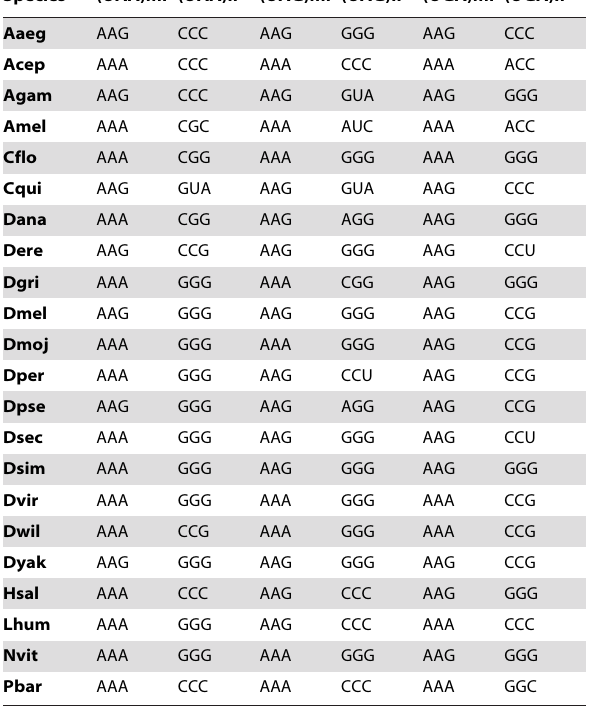
Table 6. The most frequent (mf) and least frequent (lf) 5 9 - context sequences of stop codons UAA, UAG and UGA) in different